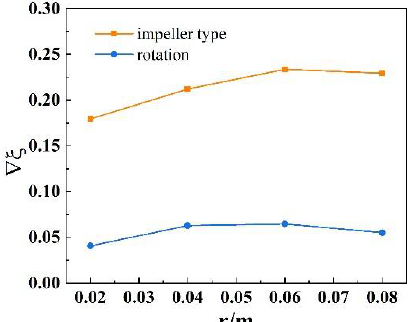
Figure 13. Comparation of homogeneity in the two systems. (Solid loading: 30%; connection strap length: 1.2 Hs).